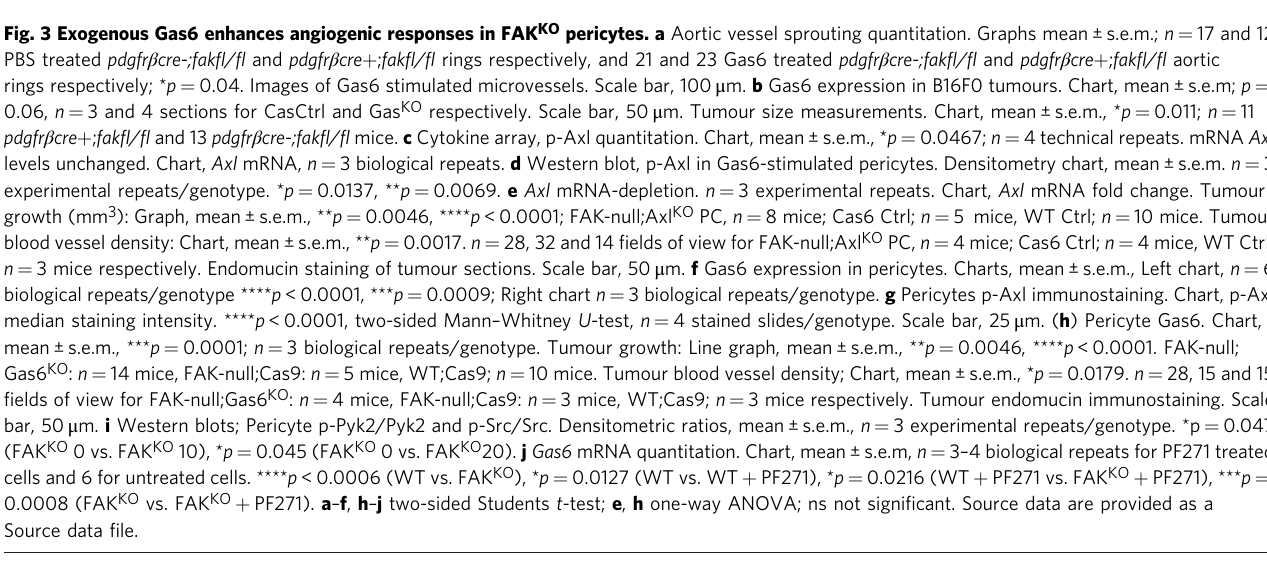
Fig. 3 Exogenous Gas6 enhances angiogenic responses in FAK KO pericytes. a Aortic vessel sprouting quantitation. Graphs mean ± s.e.m.; n = 17 and 12 PBS treated pdgfr β cre-;fak fl / fl and pdgfr β cre + ; fak fl / fl rings respectively, and 21 and 23 Gas6 treated pdgfr β cre-;fak fl / fl and pdgfr β cre + ; fak fl / fl aortic rings respectively; * p = 0.04. Images of Gas6 stimulated microvessels. Scale bar, 100 μ m. b Gas6 expression in B16F0 tumours. Chart, mean ± s.e.m; p = 0.06, n = 3 and 4 sections for CasCtrl and Gas KO respectively. Scale bar, 50 μ m. Tumour size measurements. Chart, mean ± s.e.m., * p = 0.011; n = 11 pdgfr β cre + ; fak fl / fl and 13 pdgfr β cre-;fak fl / fl mice. c Cytokine array, p-Axl quantitation. Chart, mean ± s.e.m., * p = 0.0467; n = 4 technical repeats. mRNA Axl levels unchanged. Chart, Axl mRNA, n = 3 biological repeats. d Western blot, p-Axl in Gas6-stimulated pericytes. Densitometry chart, mean ± s.e.m. n = 3 experimental repeats/genotype. * p = 0.0137, ** p = 0.0069. e Axl mRNA-depletion. n = 3 experimental repeats. Chart, Axl mRNA fold change. Tumour growth (mm 3 ): Graph, mean ± s.e.m., ** p = 0.0046, **** p < 0.0001; FAK-null;Axl KO PC, n = 8 mice; Cas6 Ctrl; n = 5 mice, WT Ctrl; n = 10 mice.